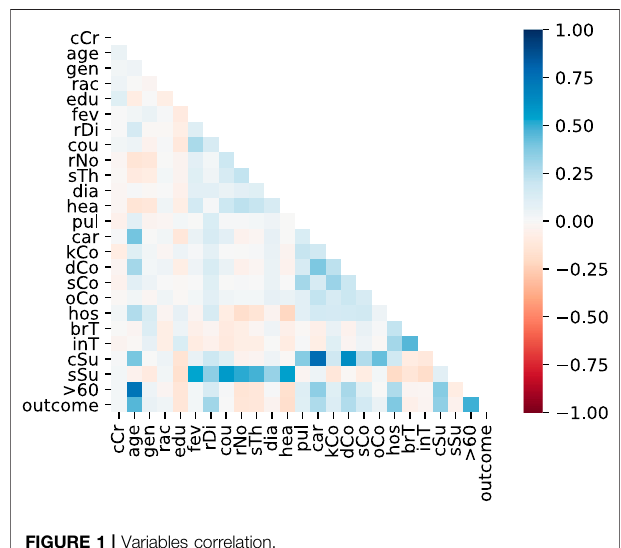
FIGURE 1 | Variables